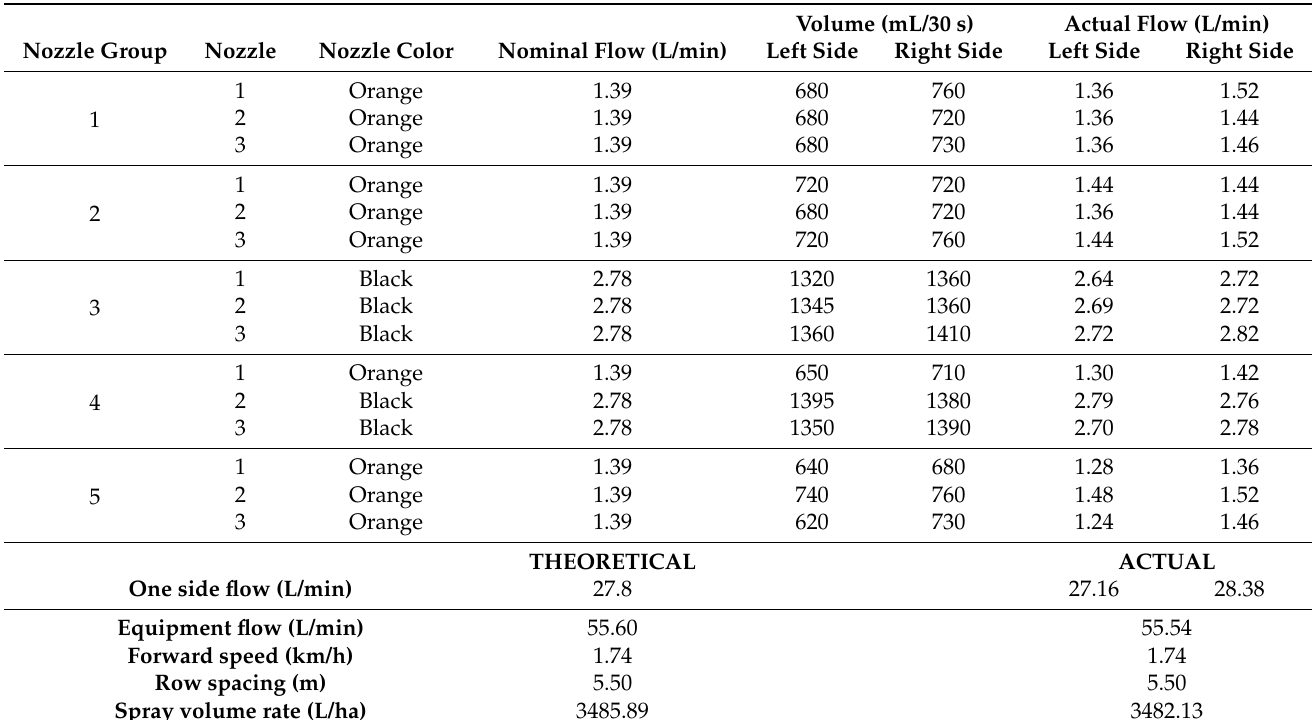
Table A4. Selection and calibration of nozzles for the T sprayer, with the following configuration: No adjusted to the vegetation/High & Low fan speed/High spray volume rate/Conventional nozzles (Fine)/Pressure: 10